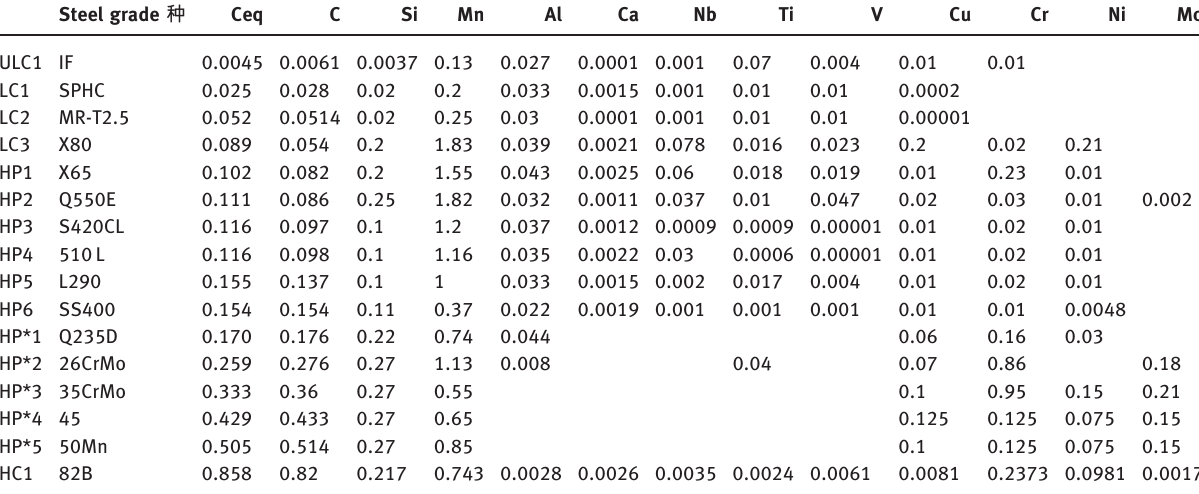
Table 1: Actual composition and carbon equivalent content of test steel grades in different solidification modes, mass%. Steel grade 种 Ceq